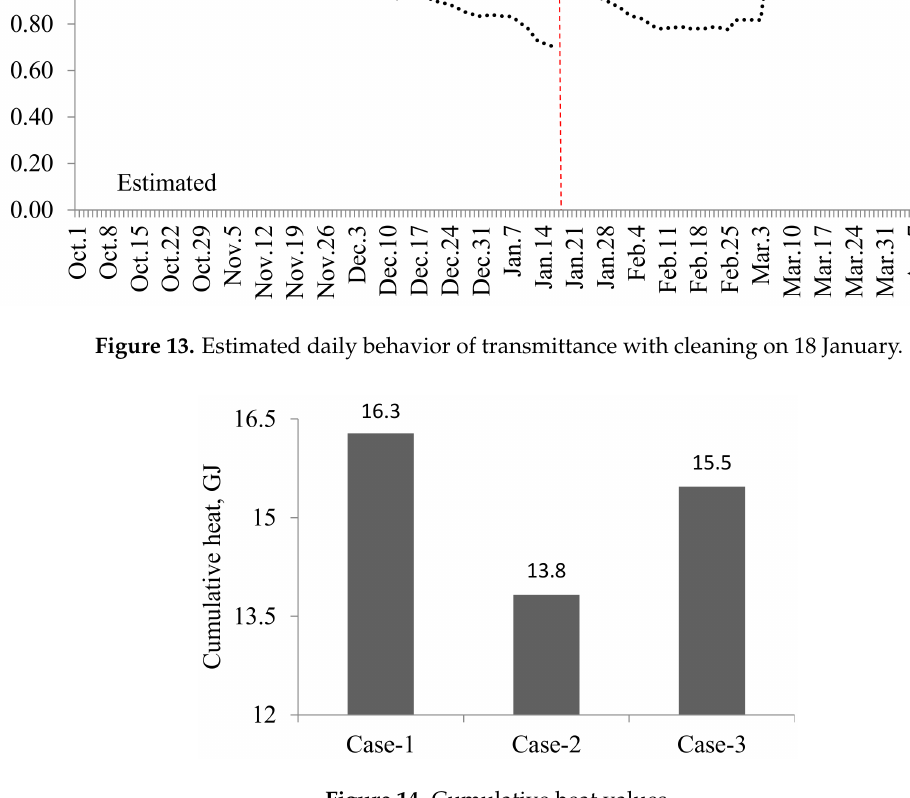
Figure 14. Cumulative heat